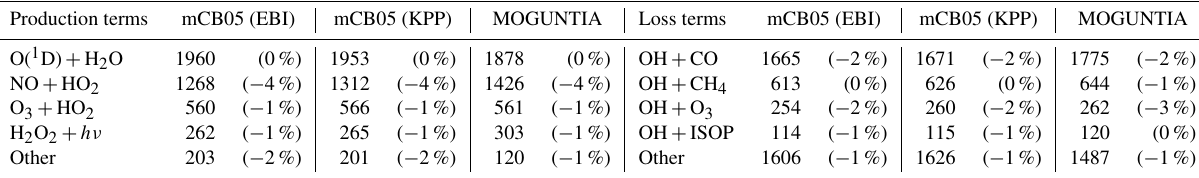
Table 5. Tropospheric chemical budget of OH for the year 2006 (Tg(OH)yr − 1 ) using the 150ppb O 3 mixing ratio to define the tropopause level. In parentheses, the relative differences using the 100ppbO 3 mixing ratios are also presented, calculated with reference to the 150ppb O 3 tropopause level